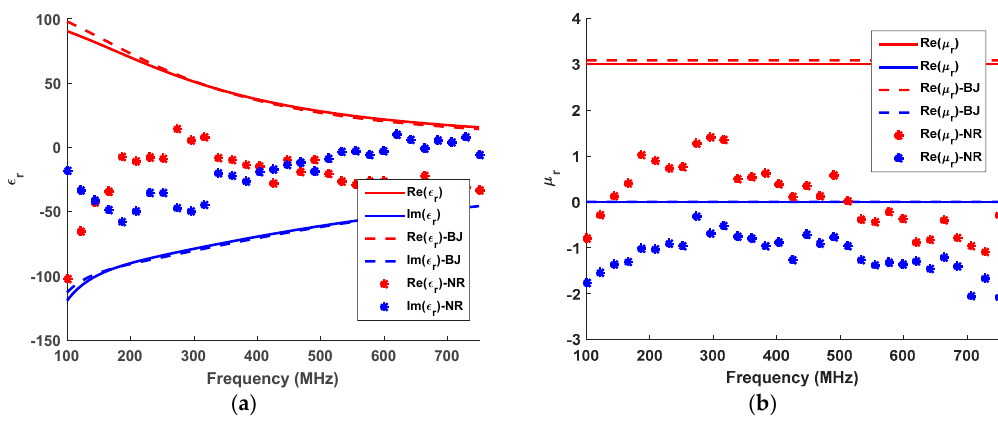
Figure 12. Real and imaginary parts of the ( a ) dielectric permittivity and ( b ) magnetic permittivity estimated with NRW and the iterative method (BJ) employing the Debye dispersion model with µ r = 3 for the case of a dielectric sample with thickness equal to 10 cm. In this case, the processed data are affected by AWGN noise with mv = 0 and σ = 0.01.